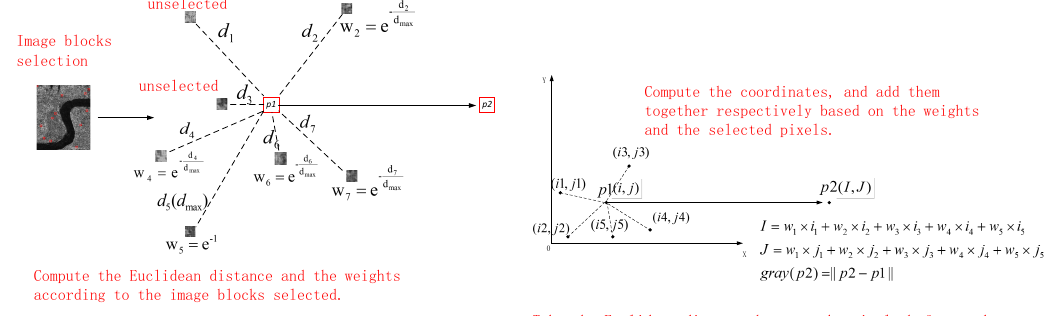
Figure 2. The process of image